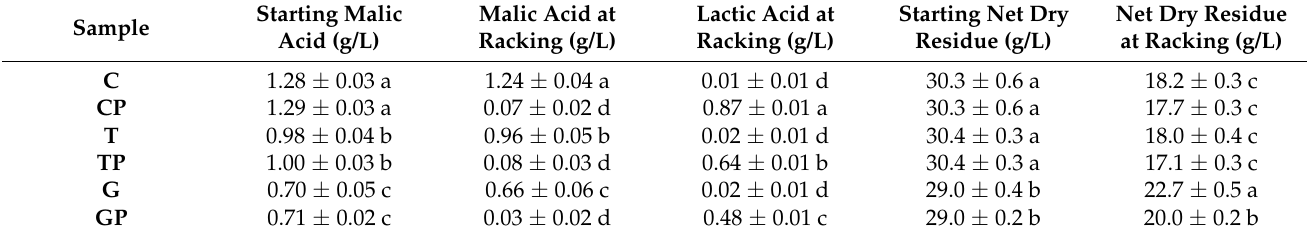
Table 5. Values of starting malic acid, malic acid at racking, lactic acid at racking, starting net dry residue, and net dry residue at racking. C = Castellina, G = Gaiole, T = Tavarnelle, CP = Castellina plantarum, GP = Gaiole plantarum, and TP = Tavarnelle plantarum.